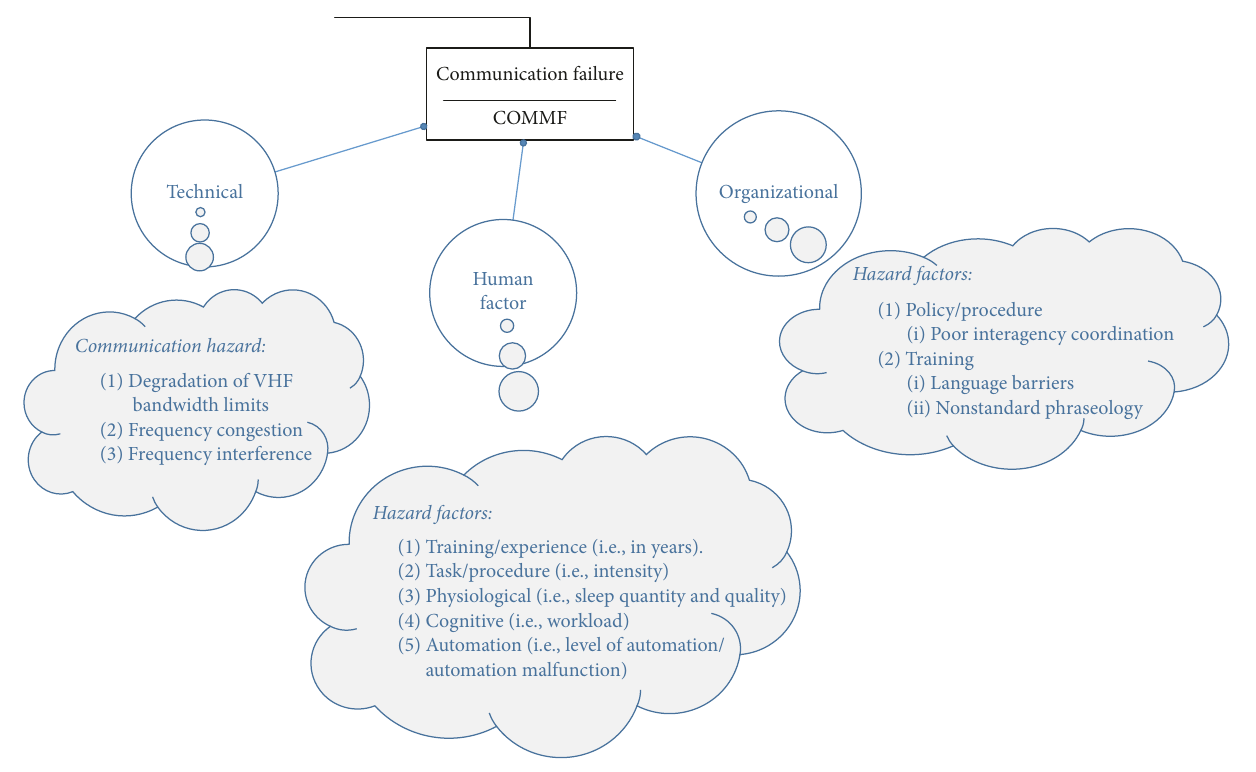
Figure 9: Example of hazard mapping to base event in fault tree.